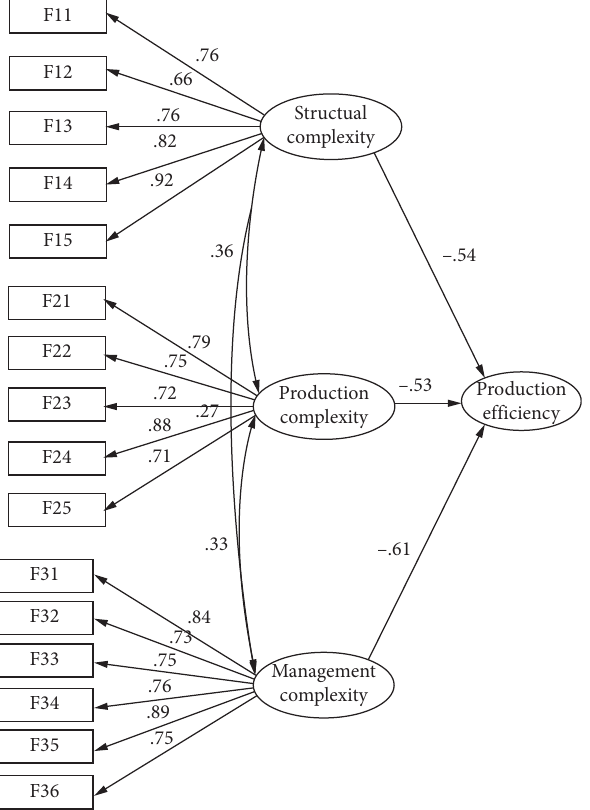
Figure 4: Second-order CFA standardized model for complexity indices with production efficiency. Table 10: Goodness-of-fit test for the second-order CFA